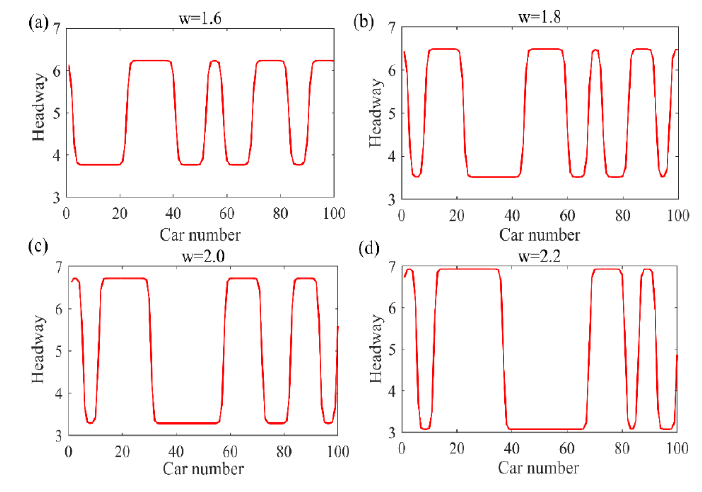
15000 t = corresponding to Figure 4, respectively. Figure 5. Profiles of the density wave at t = 15,000 corresponding to Figure 4, respectively.